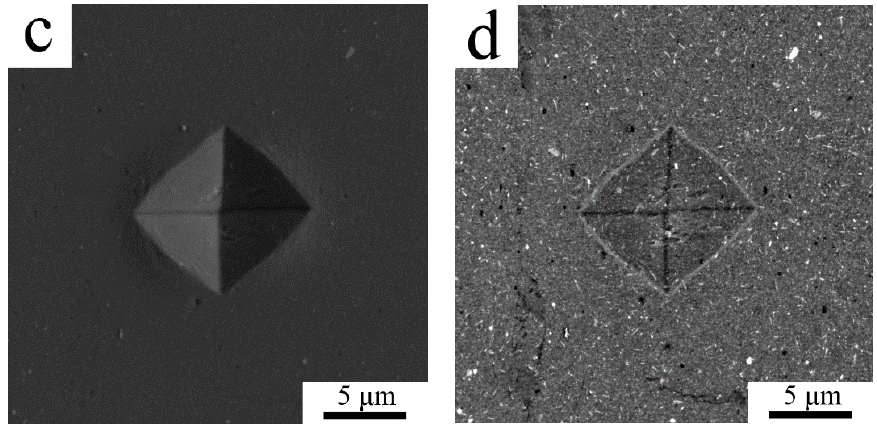
Figure 4. The indents in the sintered sample using SEM-secondary electron (SE) imaging ( a , c ) and SEM-BSE contrast ( b , d ).